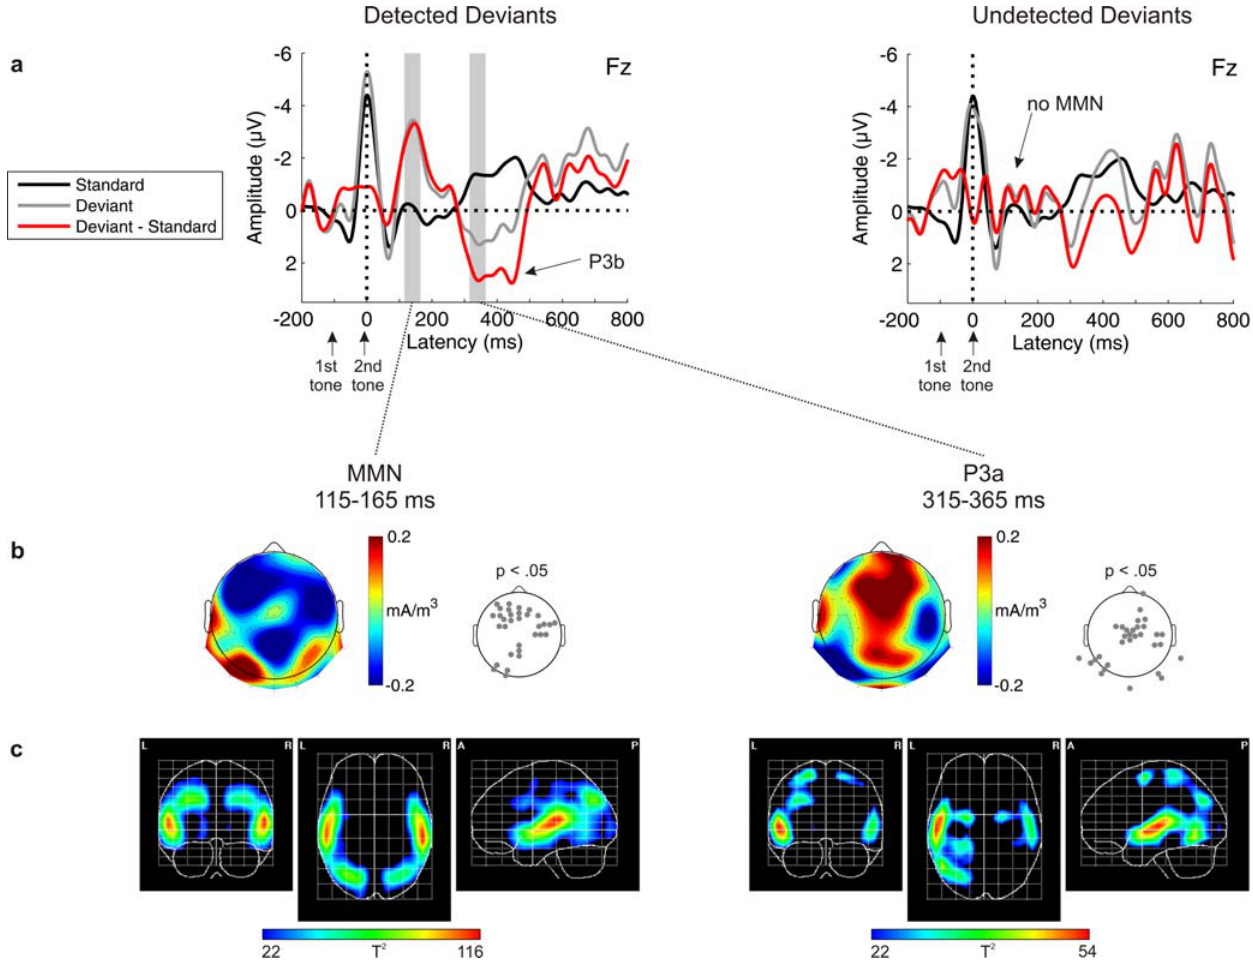
Figure 3. Detection condition for abstract rules. a) Grand-average ERPs elicited by standards (black) and deviants (gray), and deviant minus standard difference wave (red) according to detection performance (detected deviants, left; undetected deviants, right). Note that the ERPs for undetected deviants are noisier because for some subjects, only few trials with undetected deviants were observed. However, exclusion of those subjects does not change the results, i.e. MMN is still not present for undetected deviants. b) Topographic distributions of the MMN and P3a components for detected deviants (scalp current density, SCD). Electrode positions with SCD values significantly deviating from zero are indicated in the p-value maps. c) Tomographic distributions of the MMN and P3a components for detected deviants (primary current density, PCD). The hotter colors correspond to higher probability values (one-way ANOVA; thresholded to p , .0001).